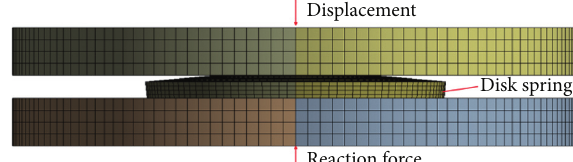
Figure 19: FE model to calculate the force-deformation relationship of disk springs.